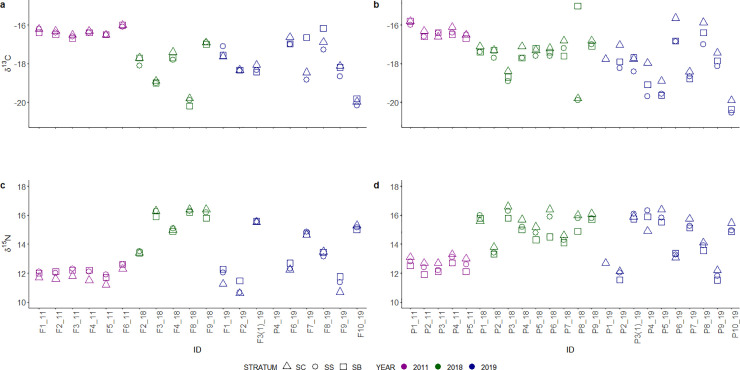
Intra-individual differences among epidermis layers normalized to SC for δ13C and δ15N values.Standard errors were represented by blue-shadowed lines.